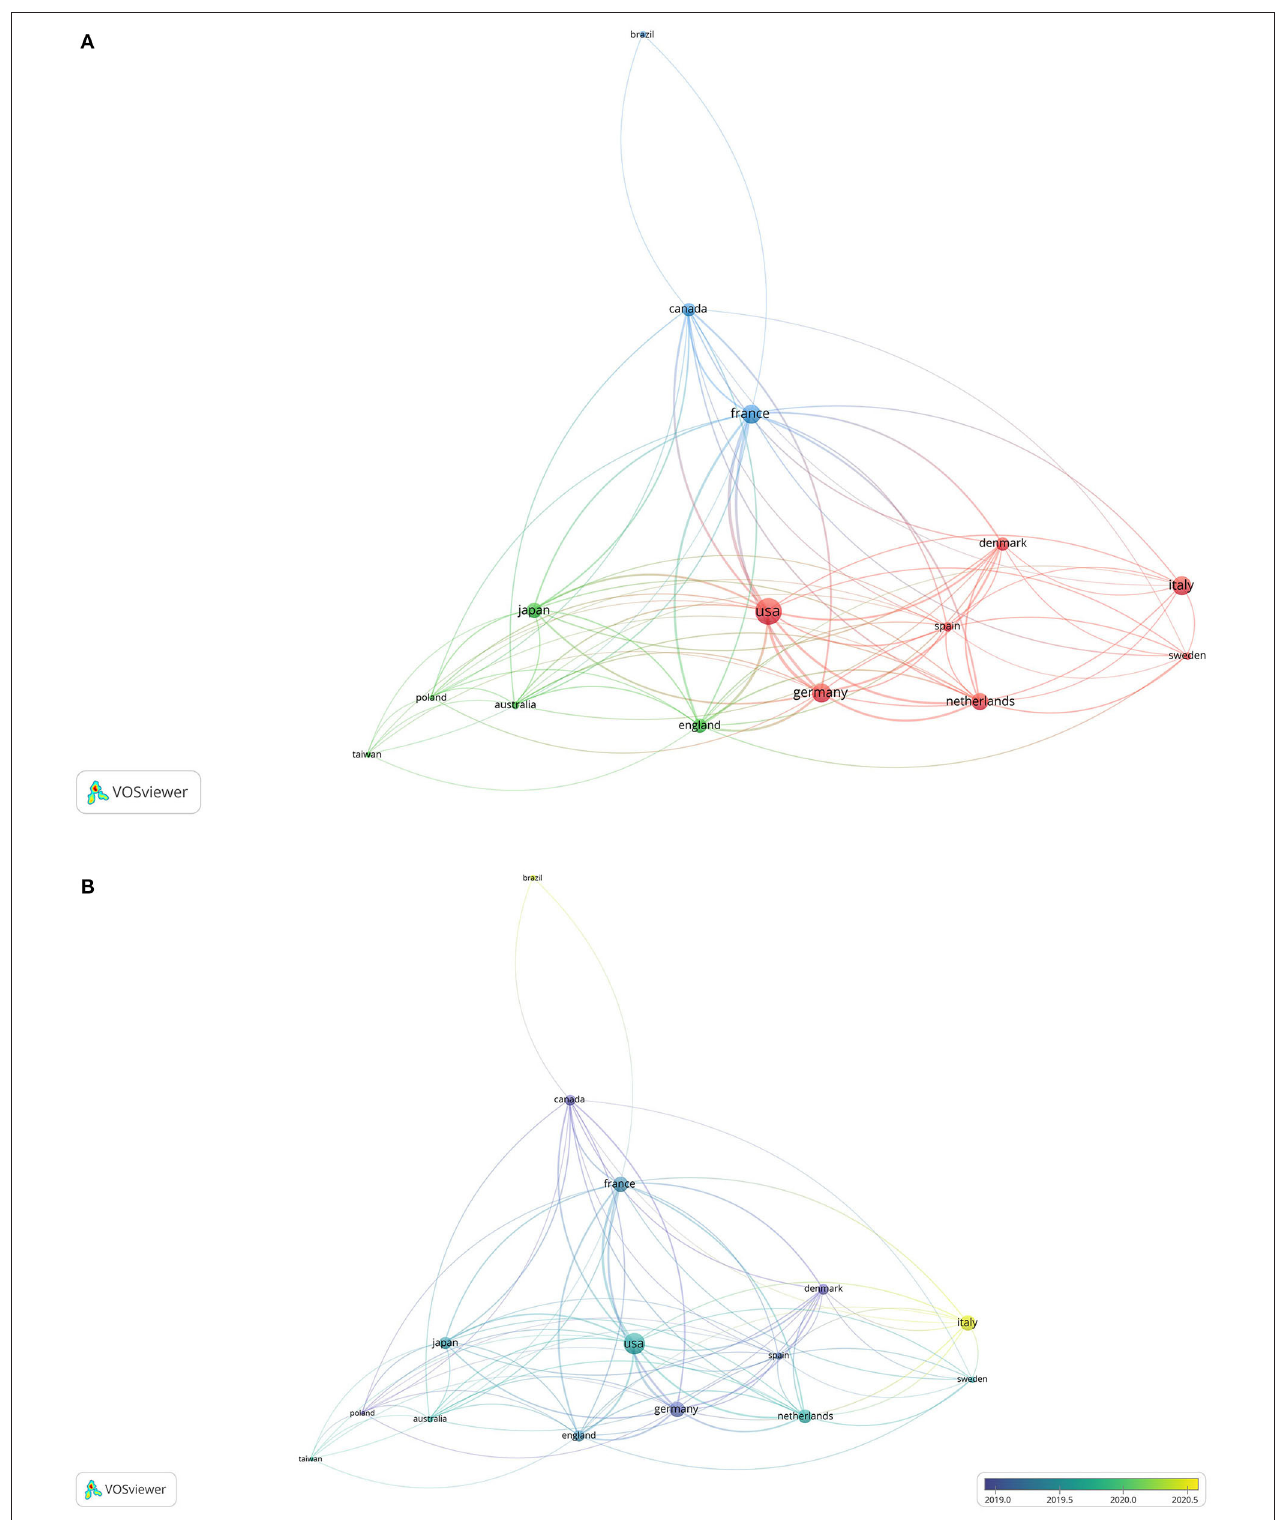
FIGURE 3 | The collaborative network among the major countries/regions. (A) Network visualization; (B) overlay visualization.